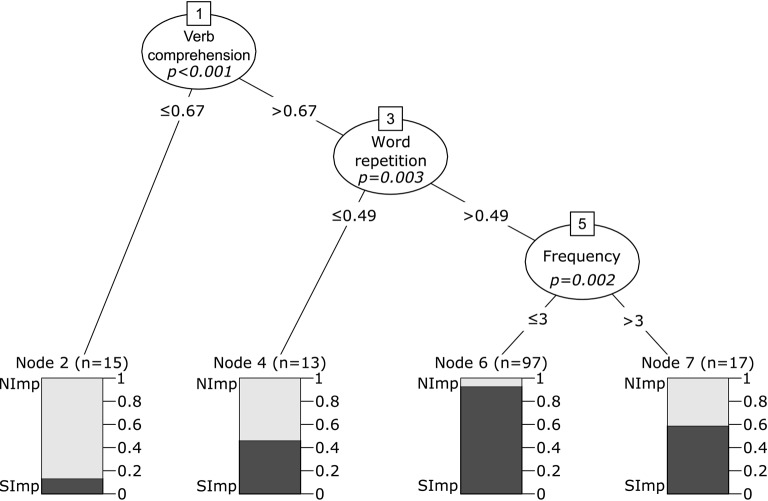
Conditional inference tree for treatment outcome for treated verbs. Nodes 1, 3, and 5 represent significant variables, with p-values presented within the node. Below each of these nodes, the values represent the points at which the node splits, therefore separating patients in groups with different outcome predictions. Each of these groups is represented by a box, and the colors in the box represent the proportion of patients within each group that showed significant improvement after treatment (SImp, in dark gray) and the proportion of patients that did not (NImp, in light gray).